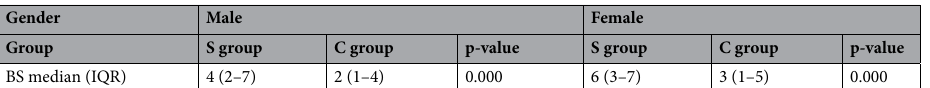
Table 4. Beighton scores in regard to gender and the group (S—study group, C—control group). S study group, C control group, BS Beighton score, IQR interquartile range.